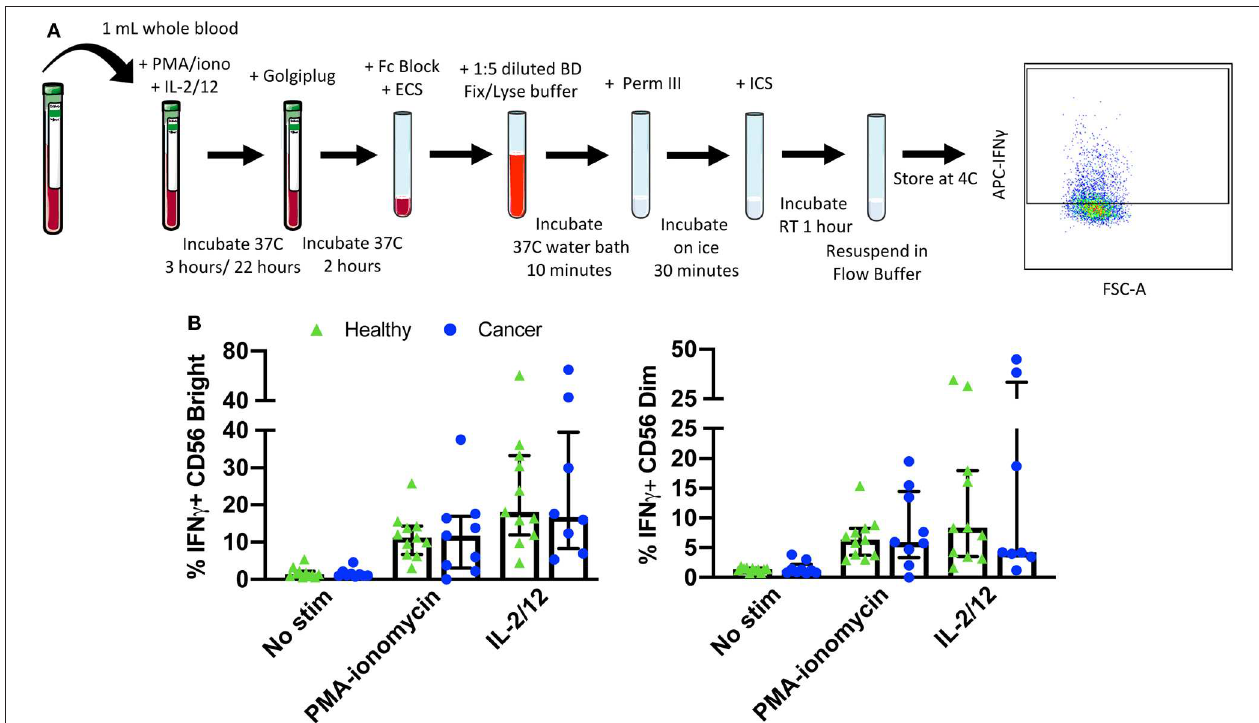
FIGURE 5 | Whole blood secretory cytokine methodology, gating strategy, and quantification. Whole blood was collected from patients and 1mL was aliquoted per stimulatory condition. Whole blood was stimulated for 24h in the presence of PMA-ionomycin or IL-2/12. At 22h post-stimulation, Golgiplug was added to whole blood and incubated for an additional 2h. At 24h post-stimulation, whole blood was incubated for 15min with an extracellular staining mix. Lyse/fix buffer was then added and incubated for 10min before blood was spun down. Cells were washed, resuspended in Perm III Buffer, and incubated on ice for 30min before being spun down and resuspended in an intracellular staining mix. Cells were then incubated for an additional 30min at 4 ◦ C prior to being resuspended and assessed by flow cytometry (A) . The lymphocyte population was gated on before excluding doublets and dead cells. CD45 + CD14 − CD56 Bright / Dim CD3 − cells were gated on to assess intracellular IFN γ based on unstimulated controls. The percentage of CD56 Bright / Dim CD3 − cells expressing INF γ after stimulation was assessed in healthy donors ( n = 11) and cancer patients ( n = 9) (B) . Shown are the median values ± IQR.